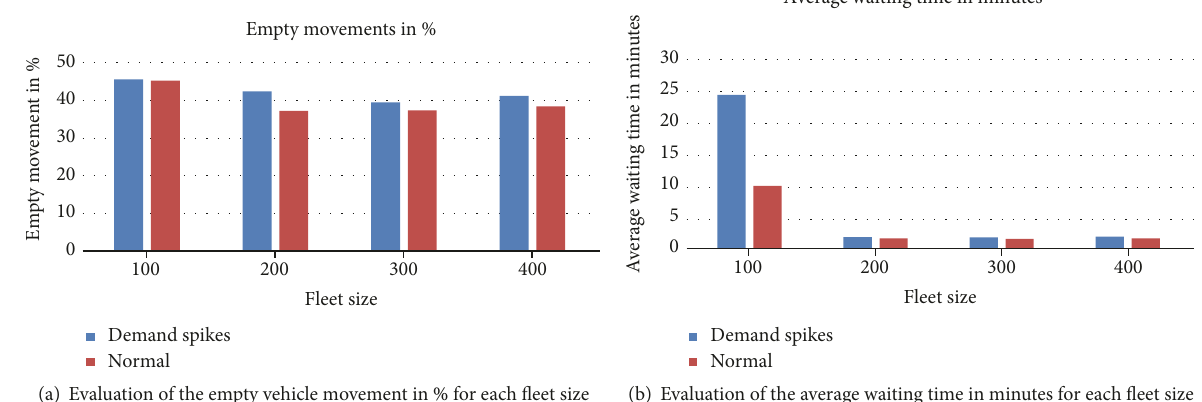
Figure 17: Pictures of the analysis of the performance of the PRT in the case of an increase of transportation demand.